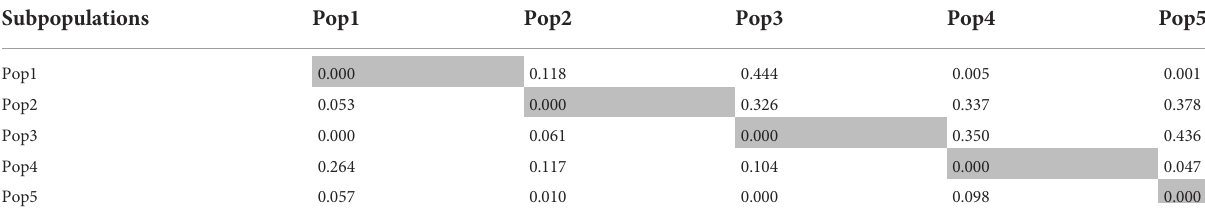
TABLE 5 Pairwise genetic distances between populations.